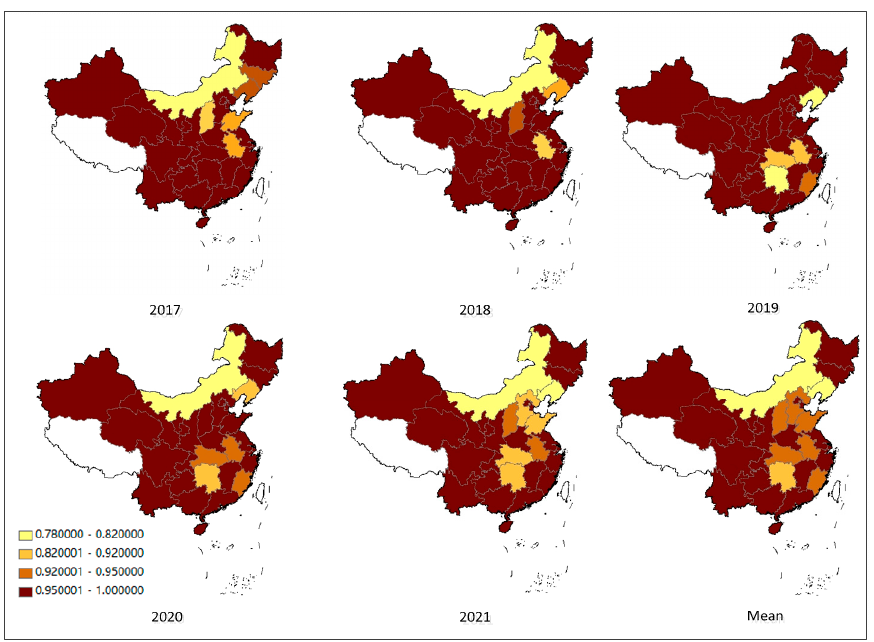
Table 4. Pure technical efficiency implementation management of green buildings during 2017– 2021.